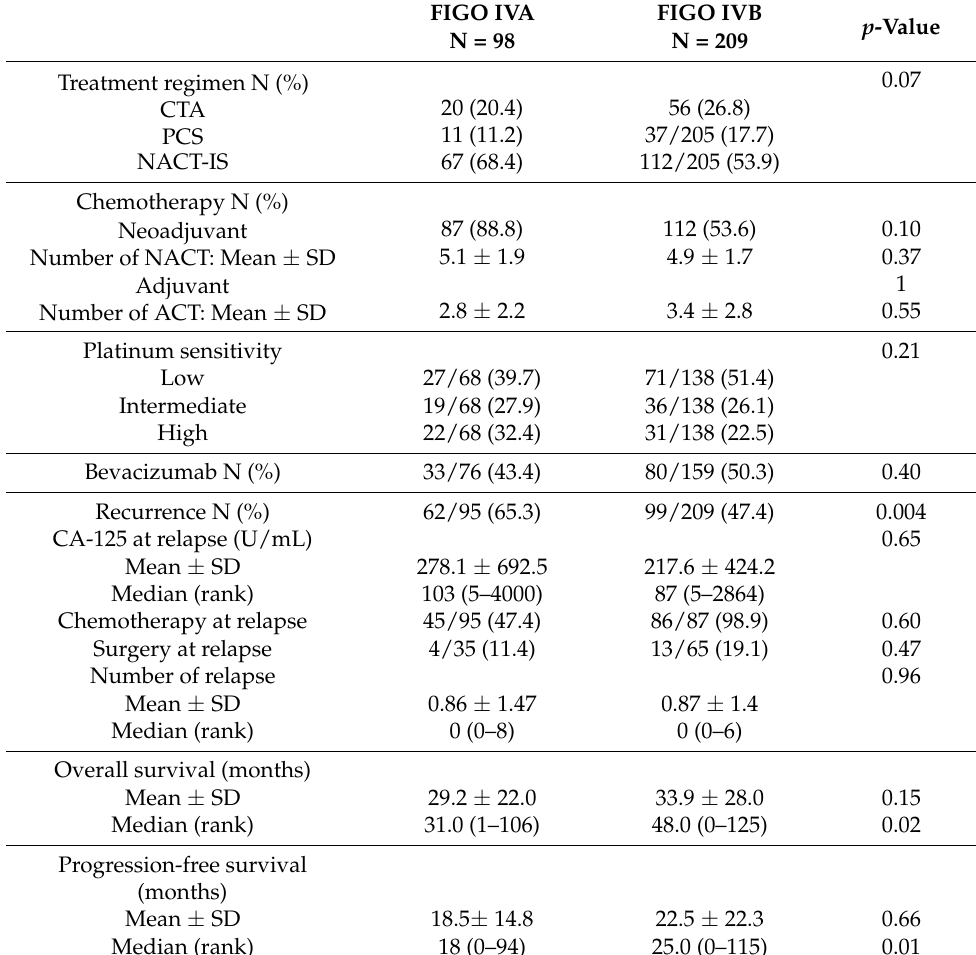
Table 2. Characteristics of the therapeutic regimens according to FIGO stage IVA or IVB. CTA: chemotherapy alone, PCS: primary cytoreductive surgery, NACT-IS: neoadjuvant chemotherapy and interval surgery, ACT: adjuvant chemotherapy, SD: standard